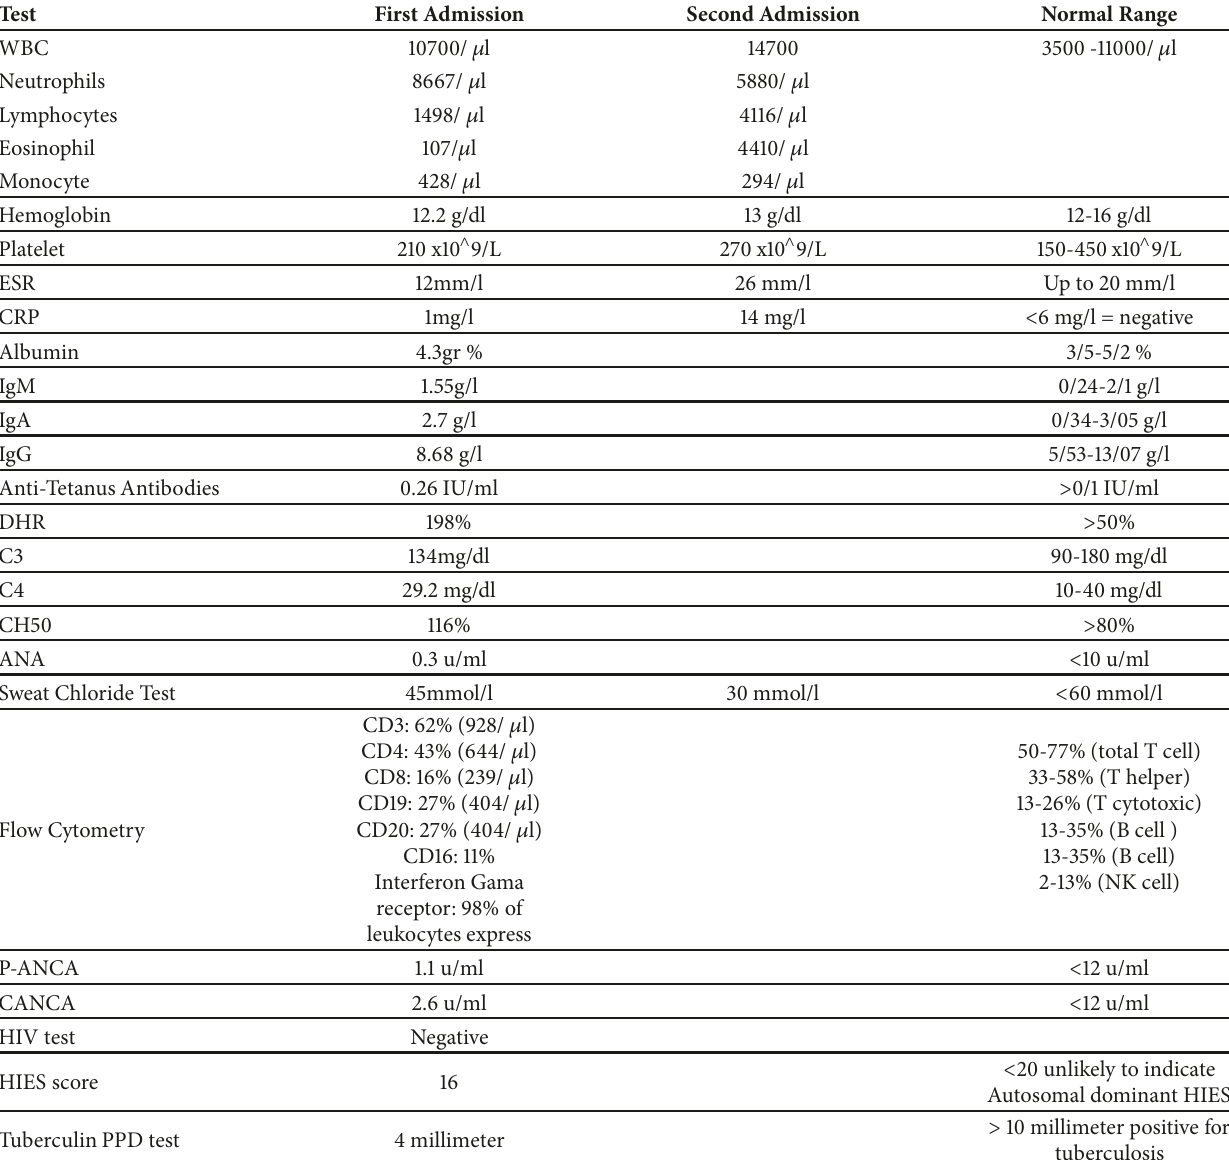
Table 1: Laboratory test results of the patient. (WBC = white blood cell, ESR = erythrocyte sedimentation rate, CRP = C-reactive protein, Ig = immunoglobulin, C = complement, CH50 = hemolytic complement, ANA = antinuclear antibodies, C-ANCA = C-anti